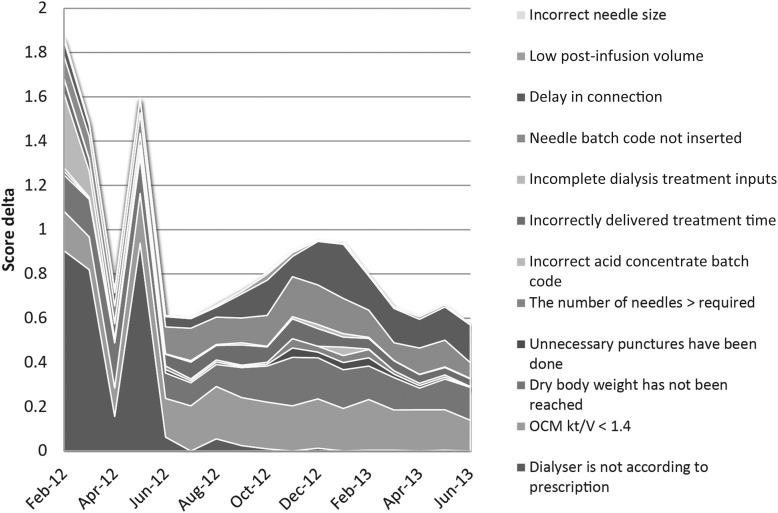
Score delta, defined as the maximum score (i.e. 15) minus the achieved score, by month and by issue.